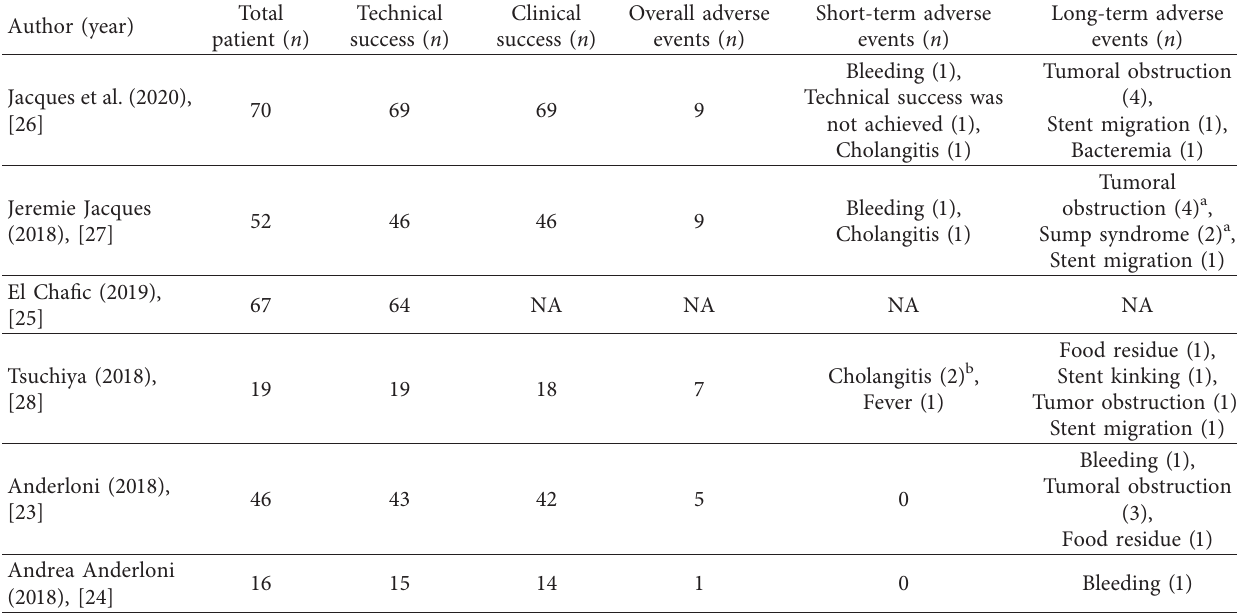
Table 2: Outcomes from studies included in the